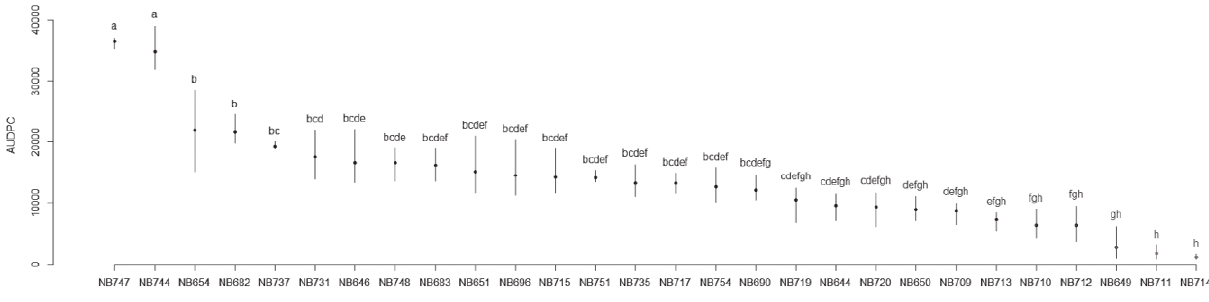
Figure 6. Mean areas under disease progress curves (AUDPCs) for disease progression on tomato plants inoculated with the different Stem- phylium spp. isolates. The data were determined at 7, 14 and 21 d after inoculation for three replicates for each isolate. Means accompanied by the same letter are not different ( P >